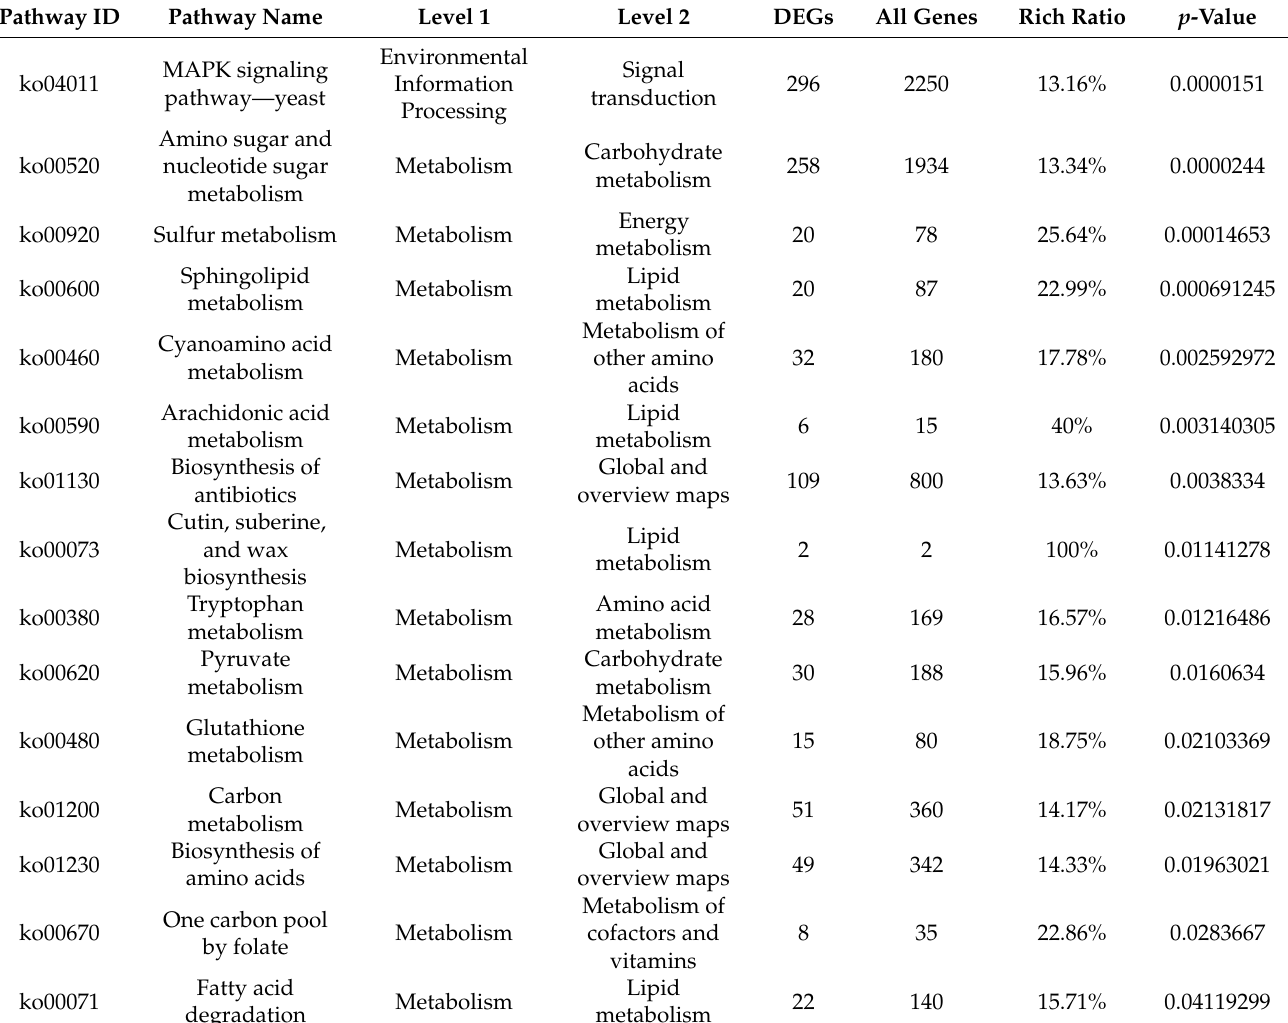
Table 1. DEG enrichment pathways according to the KEGG database ( p <